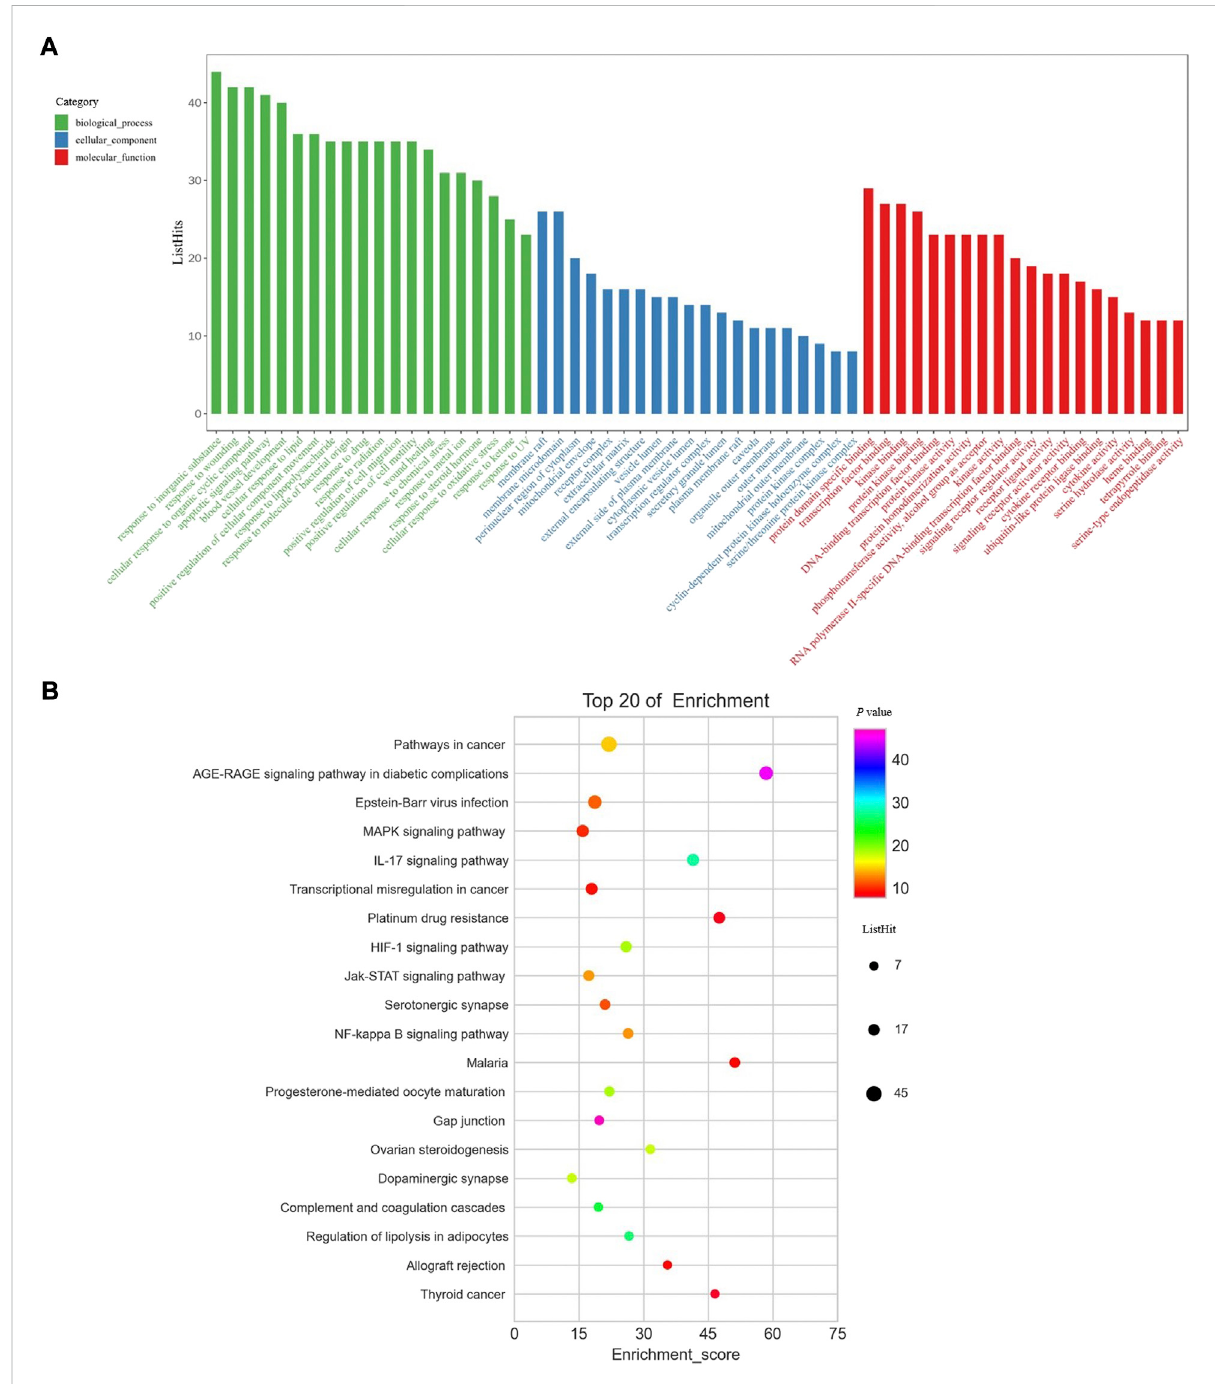
FIGURE 3 GO enrichment analysis and KEGG pathway enrichment analysis. (A) GO enrichment analysis. Green columns represent BP; blue columns represent CC and red columns represent MF. (B) KEGG pathway enrichment analysis. Abbreviation: BP, biological process; CC, cellular component; MF, molecular